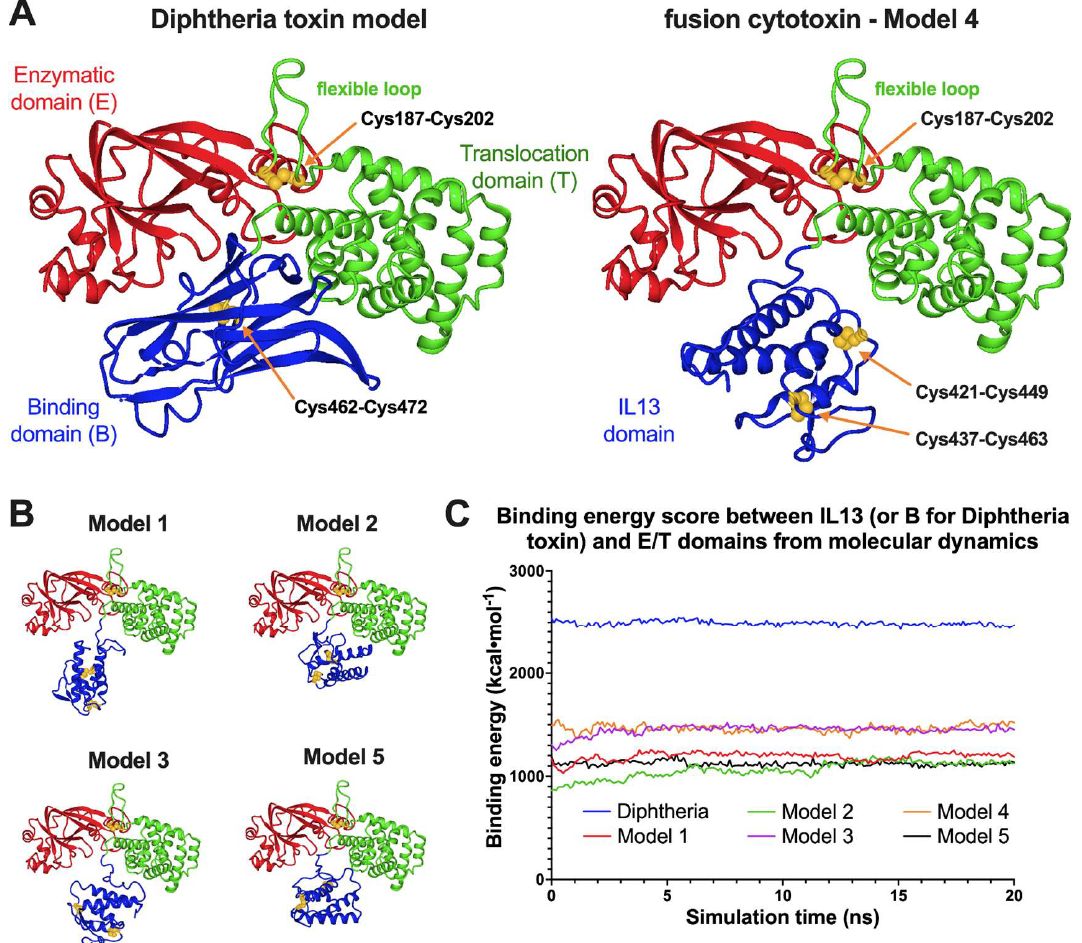
Figure 3. Molecular dynamics simulations for the diphtheria toxin and the fusion cytotoxin monomer. Presented are the ribbon representations of the last snapshots of the 20 ns MD. ( A ). Diphtheria toxin model compared to the cytotoxin Model 4, the one with the highest average DT390 and IL-13 interdomain binding energy score. ( B ). Structures of four other constructed models. ( C ). Trajectories of DT and DT390-IL-13 models as “binding energy” parameter in the function of time. Values of time-averaged binding energies between IL-13 or the DT receptor binding domain and the enzymatic/translocation domains were significantly lower for the recombinant cytotoxin than for DT (2489 kcal · moL − 1 ), with the highest for Model